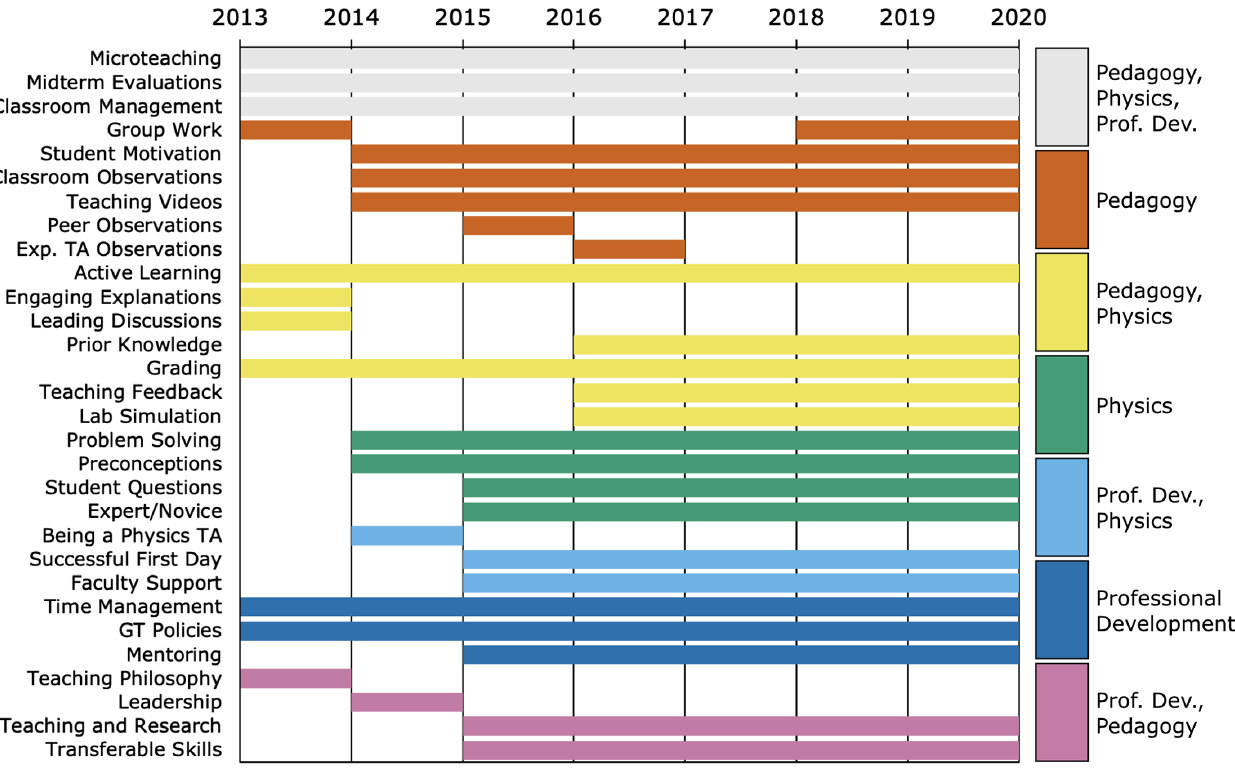
FIG. 6. Evolution of the curriculum over the years, from 2013 to 2019. Each class module, topic, or activity is color coded according to how it maps onto the 3P framework. Note that some course elements have been there since the beginning, others came and went, and others still started later and have since remained. In the end, the present-day curriculum is more robust and comprehensive than when the course first